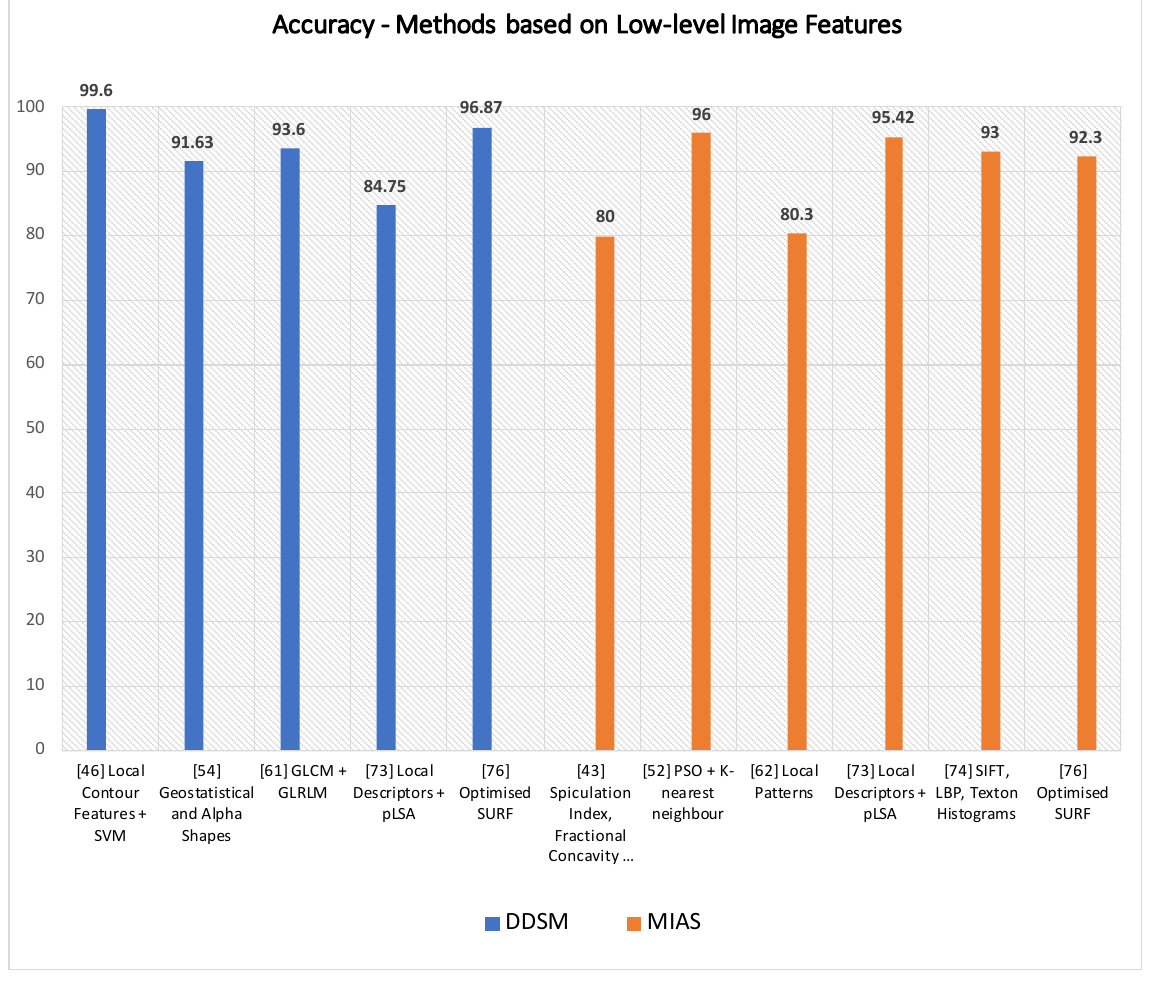
Figure 5. Some techniques based on the analysis of low-level features are plotted above according to their accuracy rates on DDSM and MIAS. Table 2. Methods based on low-level image features